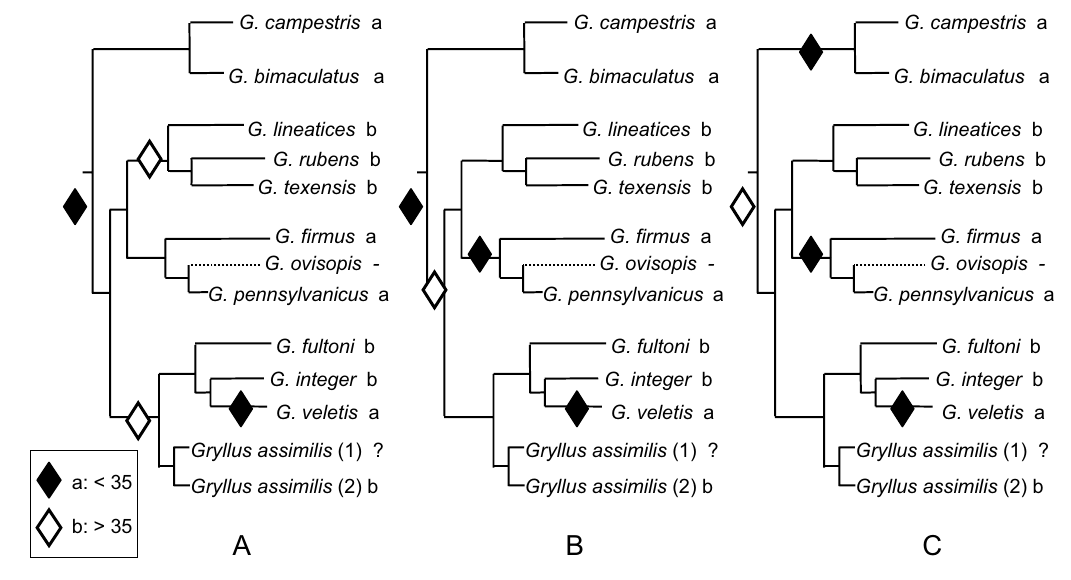
Fig. 4 – Evolution of pulse rate in Gryllus song. (A, B, C), alternative equi-parsimonious scenarios. Outgroup taxa not represented. Dotted line: song loss. After Desutter-Grandcolas and Robillard